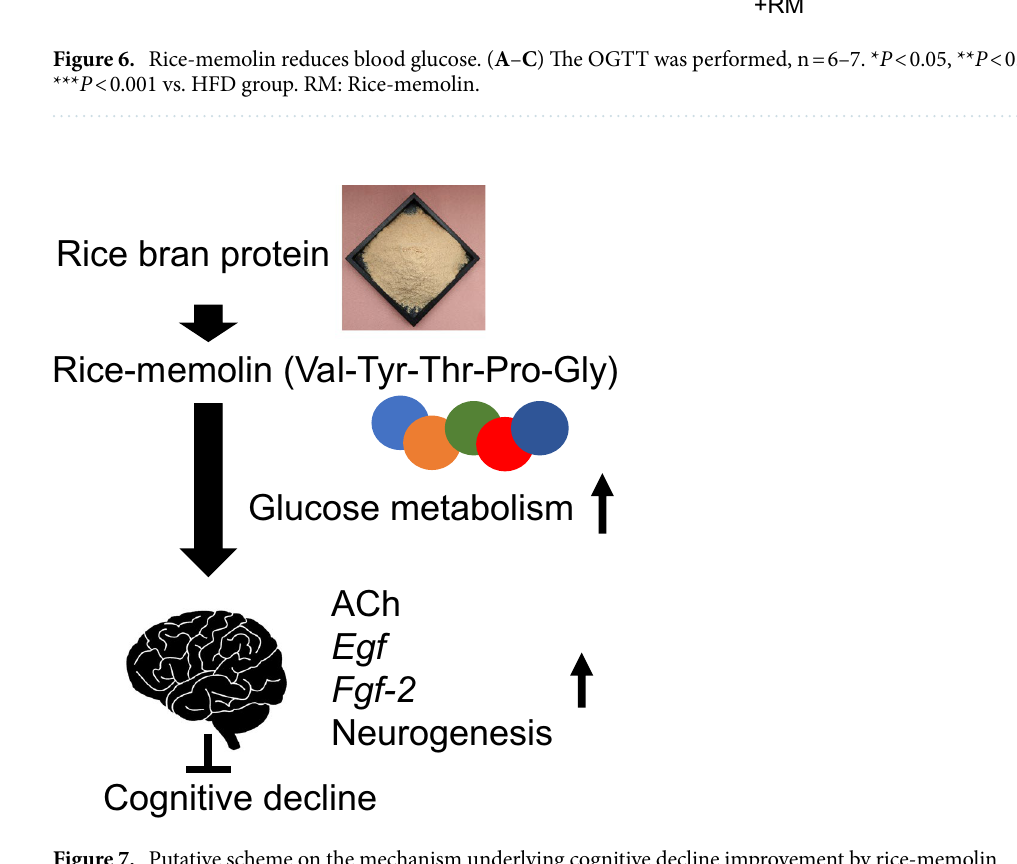
Figure 7. Putative scheme on the mechanism underlying cognitive decline improvement by rice-memolin derived from rice bran